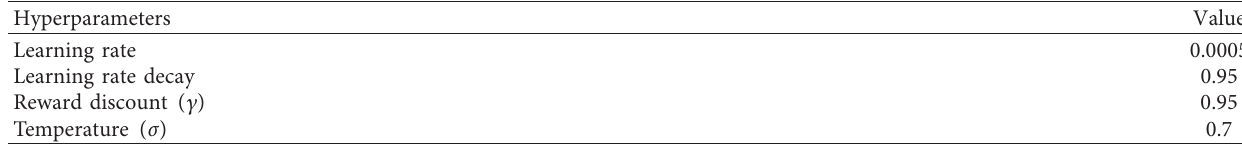
Table 2: The hyperparameters used for